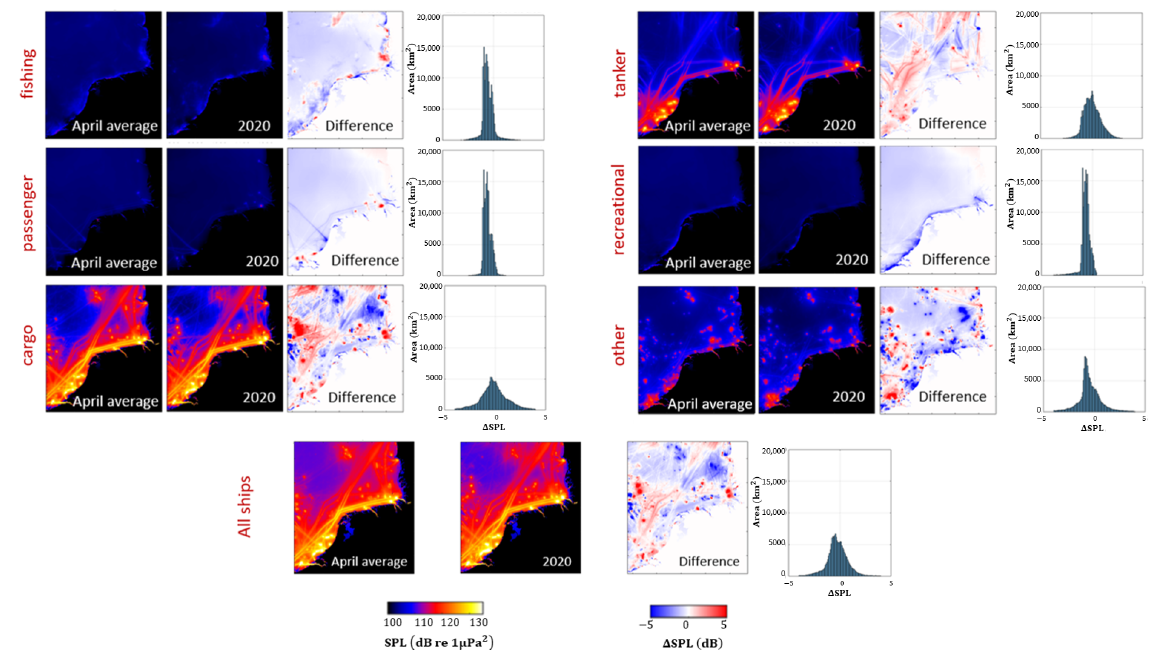
Figure 12. Comparisons for the sound maps of April Average and April 2020 for 100 Hz to 10 kHz in test area 1. The histograms show the amount of the difference in SPL per km 2 for test area 1.